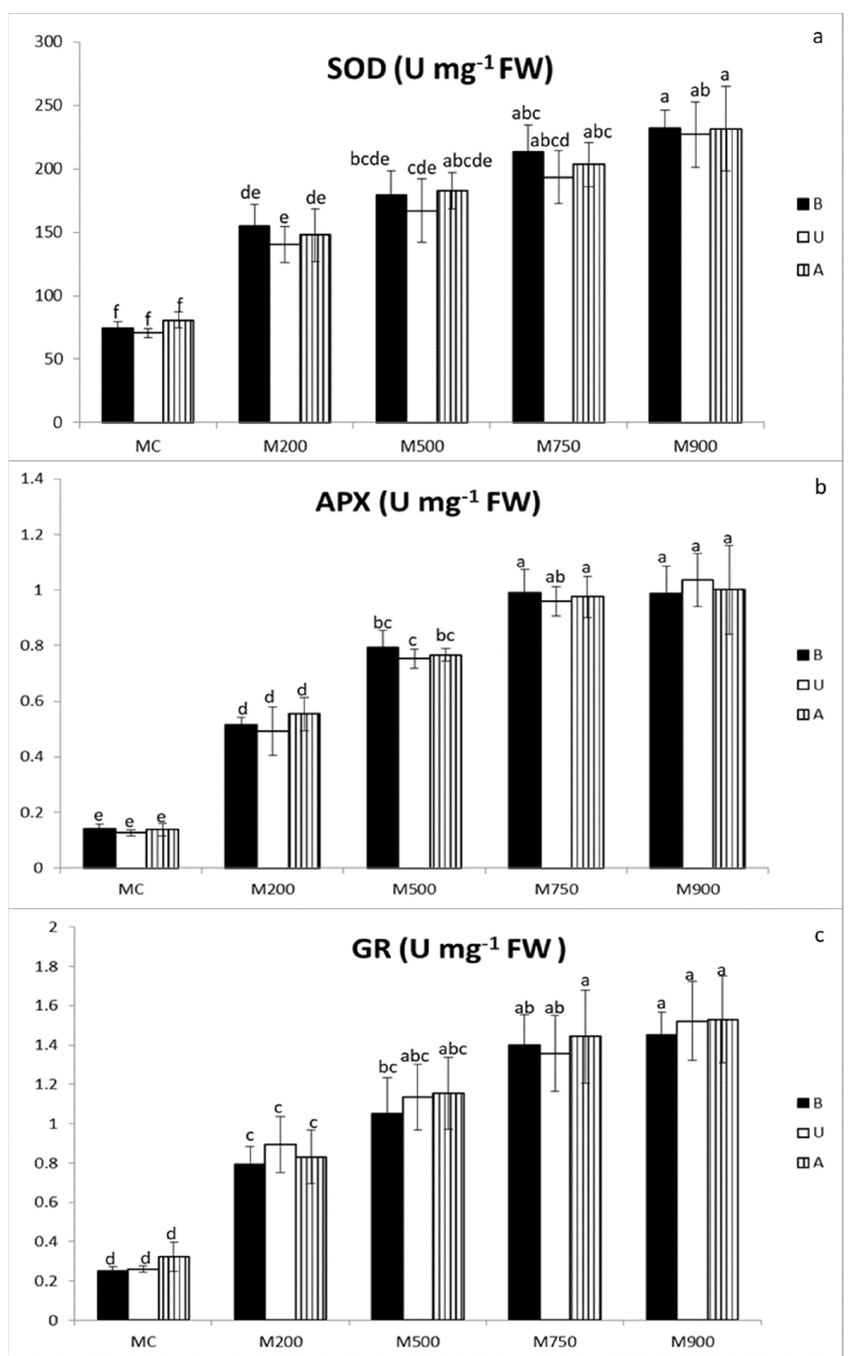
Figure 1. SOD ( a ), APX ( b ), and GR ( c ) activities in the leaves of three different miscanthus cultivars (B, U, and A) cultivated in soils with gradient TE concentrations (MC, M200, M500, M750, and M900). Values are presented as means ± SD. Different letters refer to significant differences between plants (Turkey HSD test, n = 5, p ≤ 0.05).